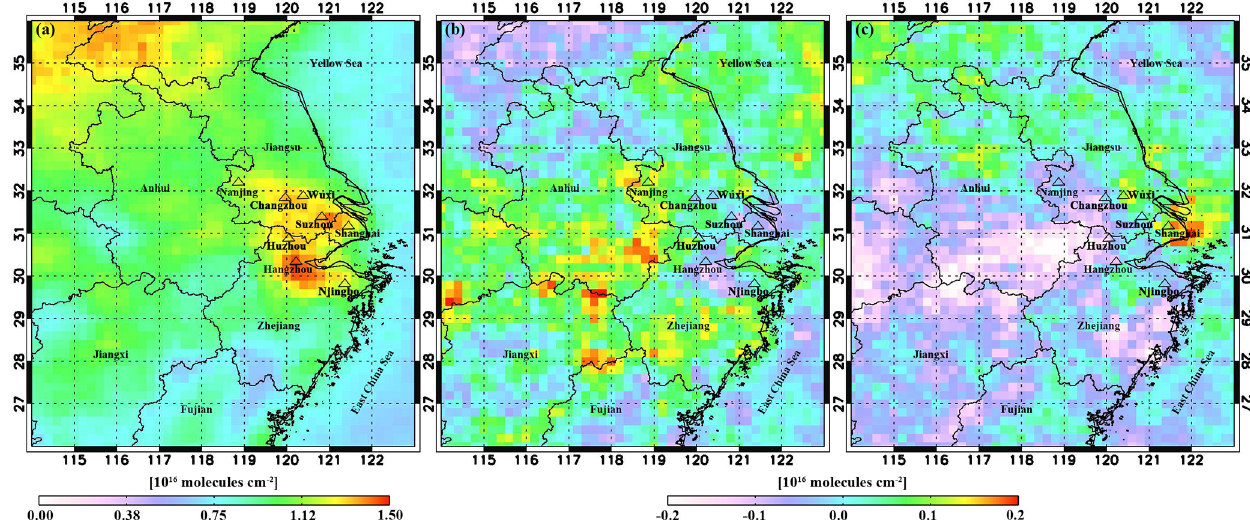
Figure 4. (a) The spatial distribution of annual mean tropospheric HCHO column observed by OMPS in the YRD in 2015, and (b) changes in the HCHO VCDs between 2016 and 2015 and (c) between 2017 and